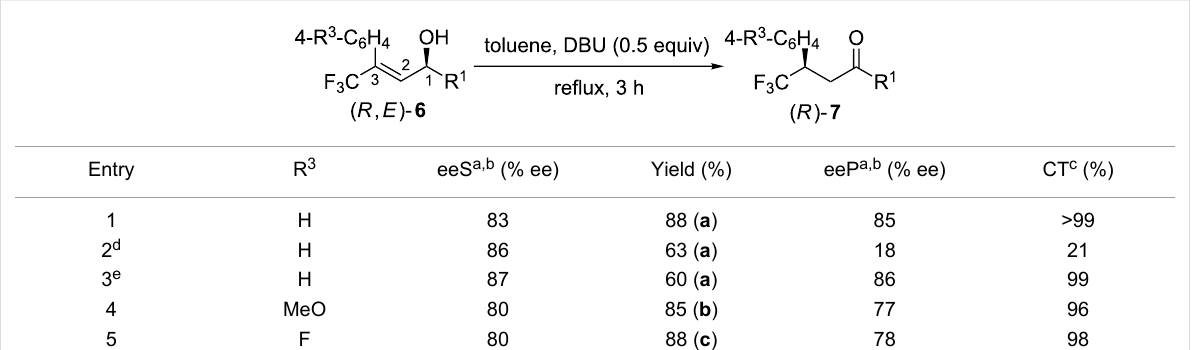
Table 4: DBU-promoted proton shift of the chiral allylic alcohols ( R , E )- 6